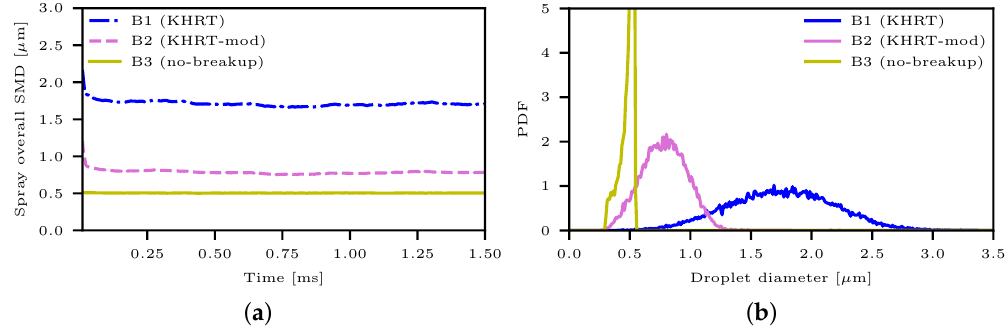
Figure 7. ( a ) Temporal evolution of the global SMD of liquid droplets. ( b ) Probability density function (PDF) of liquid droplets diameters at time 0.5 ms after